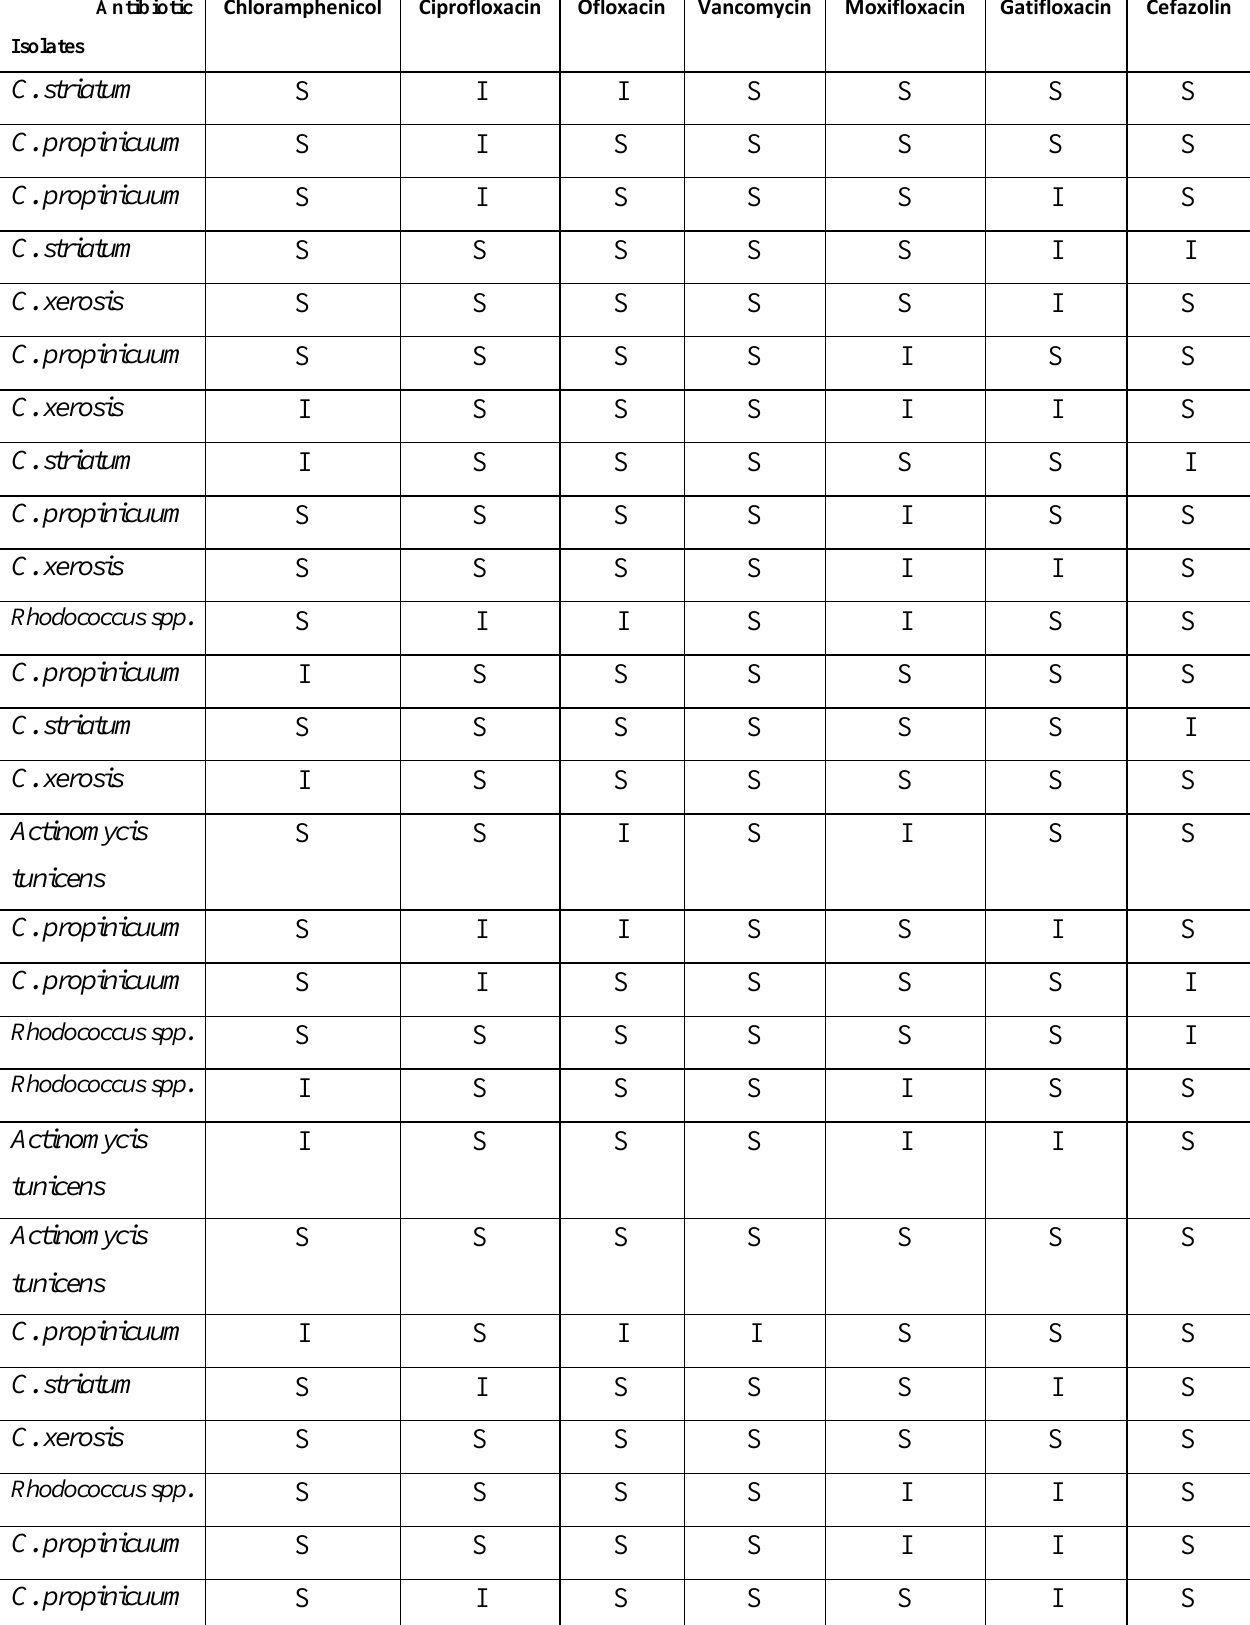
Table 2: Antimicrobial sensitivity pattern of Corynebacterium spp. in the present study